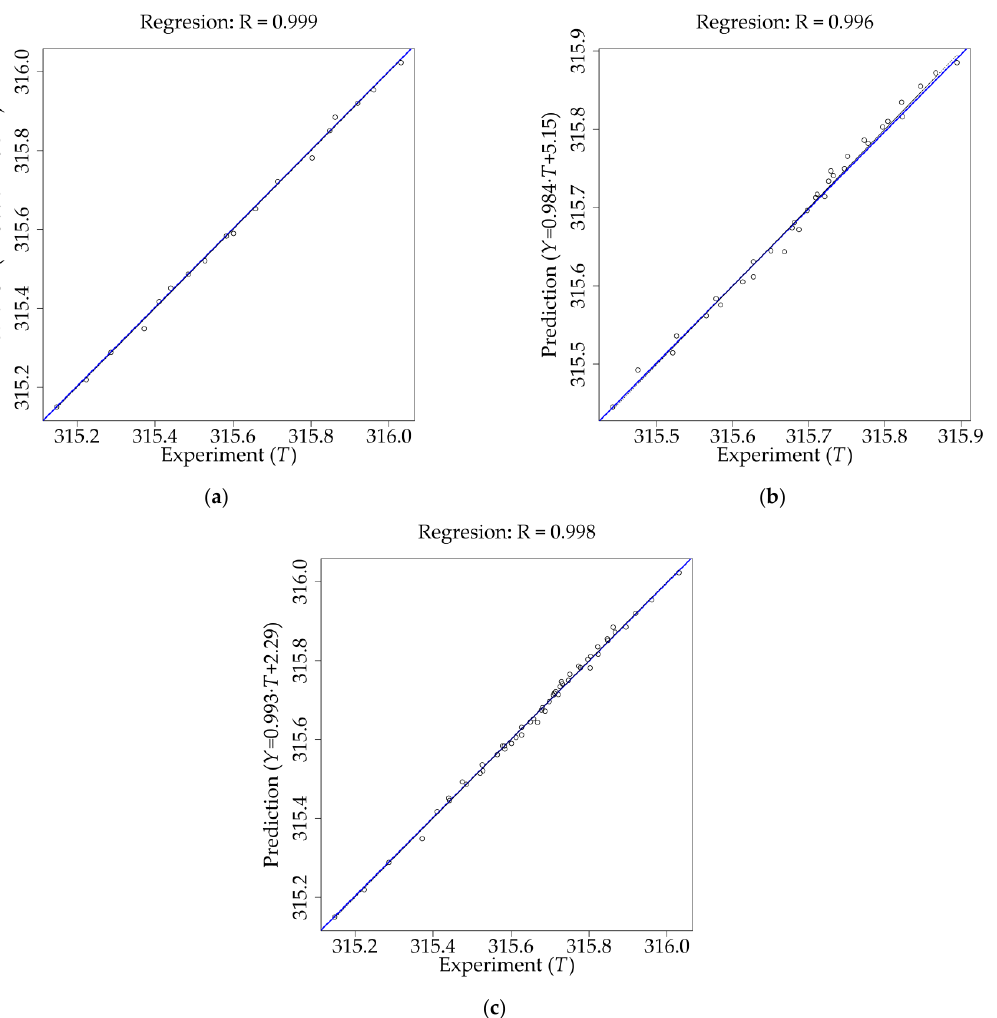
Machines 2023 , 11 , x FOR PEER REVIEW Figure 5. Regression plots for Linear regression model (LR): ( a ) training data; ( b ) testing data; ( c ) all data. As shown in Figure 6, the graphical output of the model shows how the resulting dimension of the part is related to the welding speed and current, specifically for the di- mension of the stampings Z = 316.00 mm.